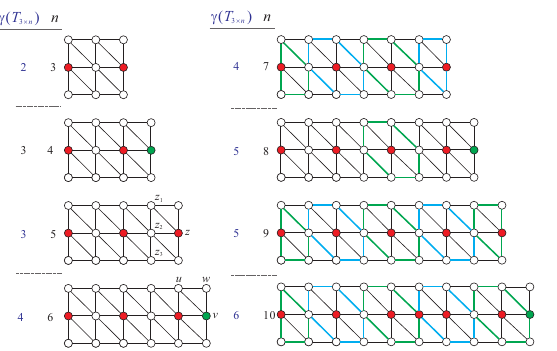
(cid:99) + 1 for 3 (cid:54) n (cid:54) 10; filled circles indicate the vertices in the 2